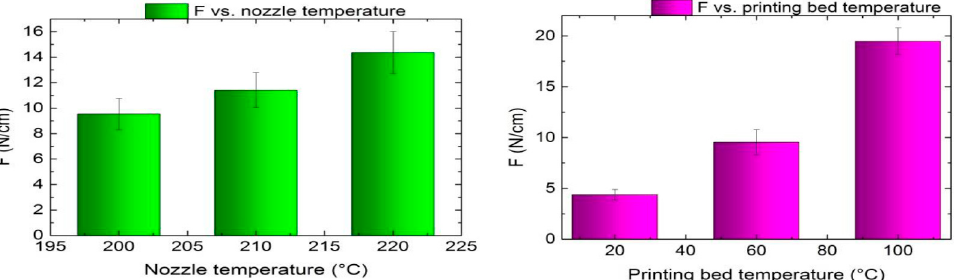
Figure 4. Example of the dependence of the adhesion force on the temperature of nozzle ( left ) and bed ( right ) [77] at the specific conditions and materials reported in [77], tested according DIN 53,530 and evaluated according DIN ISO 6133.